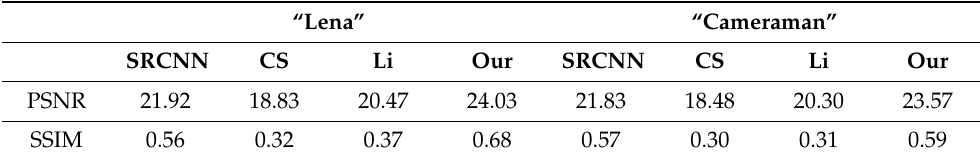
Table 1. Comparative analysis of different recovery methods with a sampling rate of 18.3% and scattering condition (the signal to noise ratio is 10 dB).